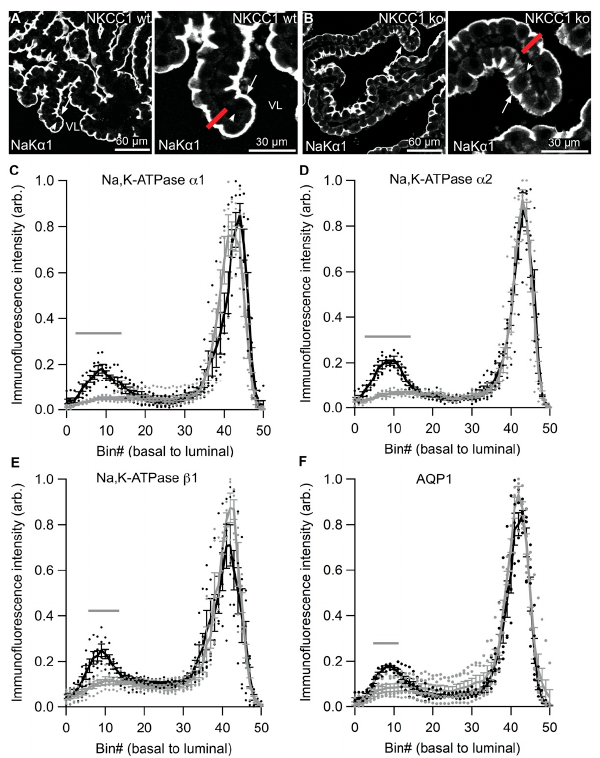
Figure 12. Cross-cellular labeling profiles for Na,K-ATPase and AQP1 in NKCC1 deficient mouse CPECs. ( A ) The Na,K-ATPase α 1 (NaK α 1) intensity in CPECs from NKCC1 wildtype (wt) mice was quantified by drawing an 11-pixel-wide line (red line) across two cells from each micrograph. The right panel is a higher magnification representation of the left panel. The number of cross cellular basal--to-apical pixels was then compressed to 50 bins for each cell. ( B ) Similar labeling analysis was performed on images of Na,K-ATPase α 1 (NaK α 1) staining in CPECs from NKCC1 ko mice. Arrows indicate luminal surfaces, while arrowheads mark basolateral surfaces. VL denotes the fourth ventricle lumen. ( C ) Graph showing the average Na,K-ATPase α 1 staining intensity (arbitrary units) for each of the 50 bins in CPECs from NKCC1 wt (grey) and ko (black) mice ( n = 5). ( D ) Similar graphs showing the cross-cellular Na,K-ATPase α 2 labeling profiles in CPECs from NKCC1 wt (grey) and ko (black) mice ( n = 5). ( E ) Graph showing the cross-cellular Na,K-ATPase β 1 labeling profiles in CPECs from NKCC1 wt (grey) and ko (black) mice ( n = 5). ( F ) Graph showing the cross-cellular AQP1 labeling profiles in CPECs from NKCC1 wt (grey) and ko (black) mice ( n = 5). Bin #1 represents the basal end of the cell, while bin #50 the luminal end. Individual observations are indicated as points, and error bars represent SEM. Grey horizontal bars represent bins with a significant difference in staining intensity between NKCC1 wt and ko mice. P -values are given in Supplemental Table S1.